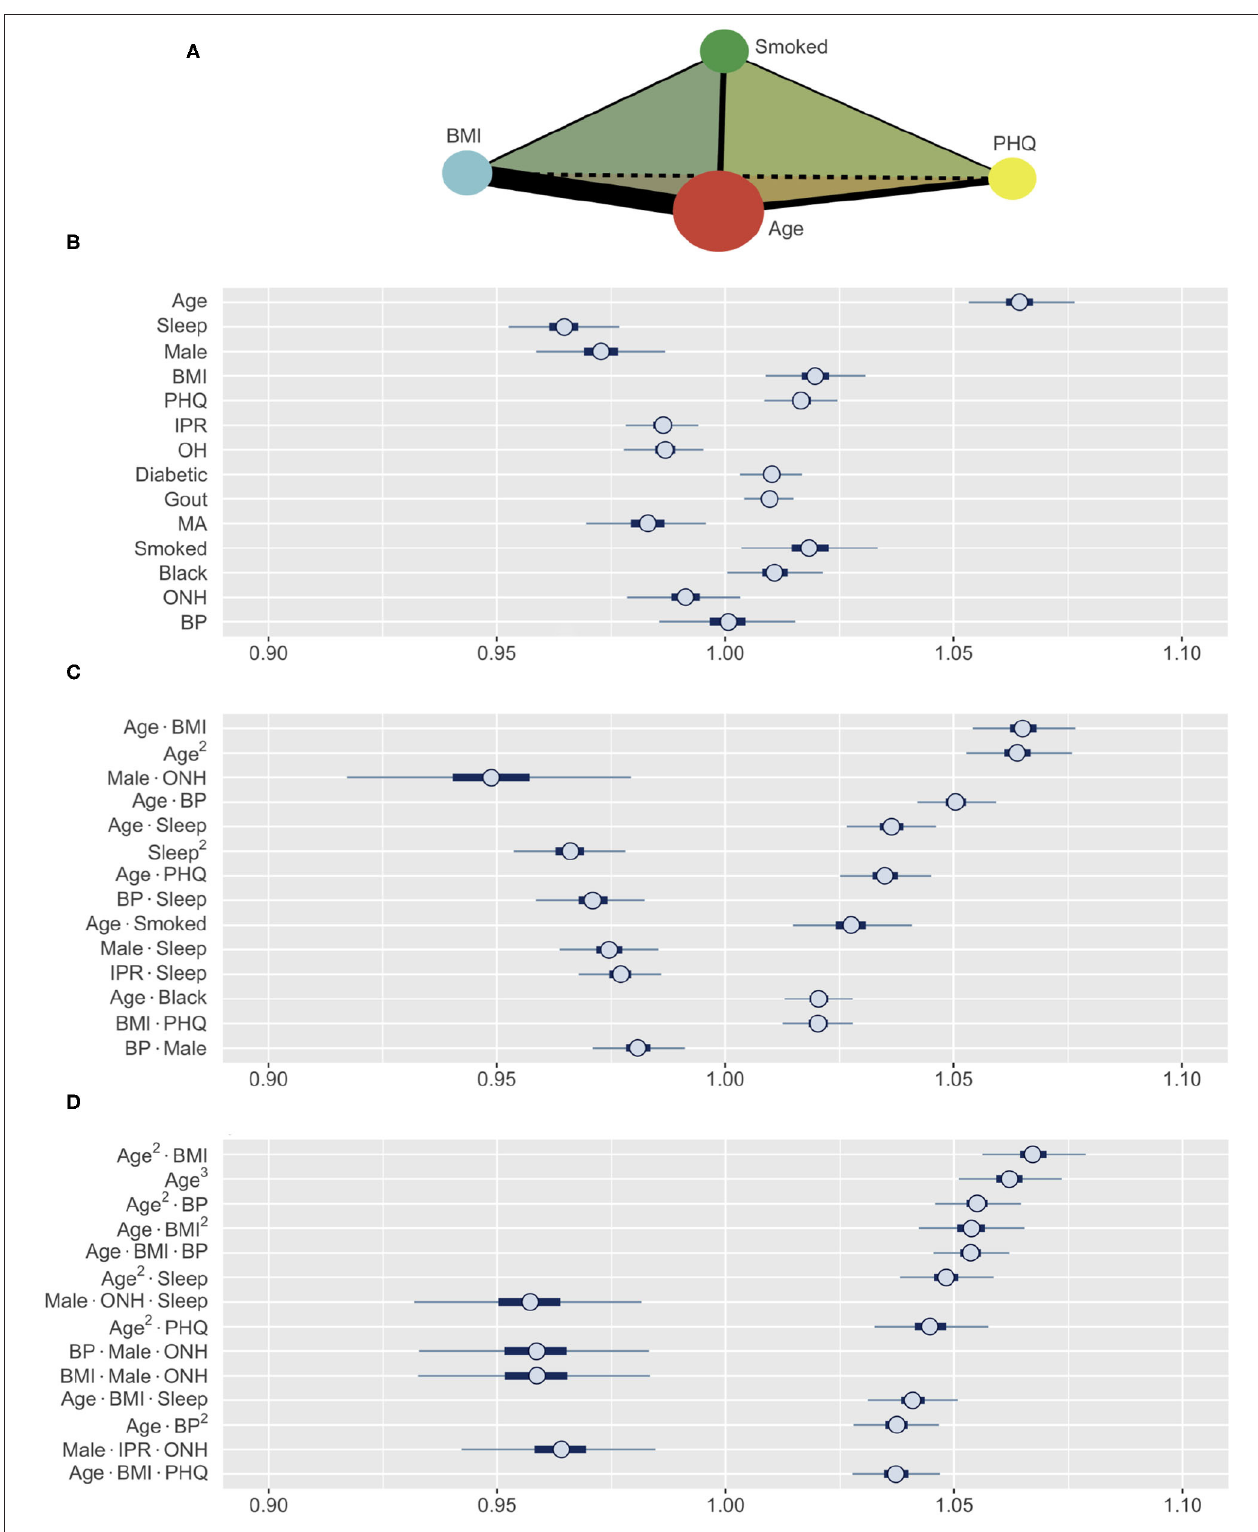
FIGURE 5 | (A) A schematic illustrating the interaction analysis between four risk factors. Size of vertices, thickness of edges, and color of faces denote the size of first-, second-, and third-order effects, respectively. (B–D) Posterior distributions of standardized coefficients for selected variables. HDIs for (B) all first-order variables, (C) most influential second-order, and (D) third-order variables (inner bounds, 50% HDIs; outer bounds, 99% HDIs). Horizontal scale represents the odds multipliers for risk of RA for one standard deviation increase in value of the variables. MA, Mexican-American; OH, Other Hispanic; ONH, Other Non-Hispanic.